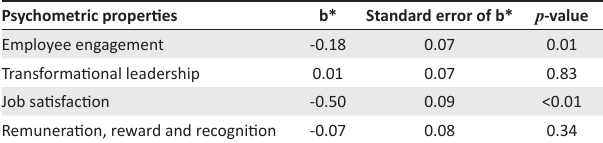
TABLE 6: Multiple regression model summary ( N =